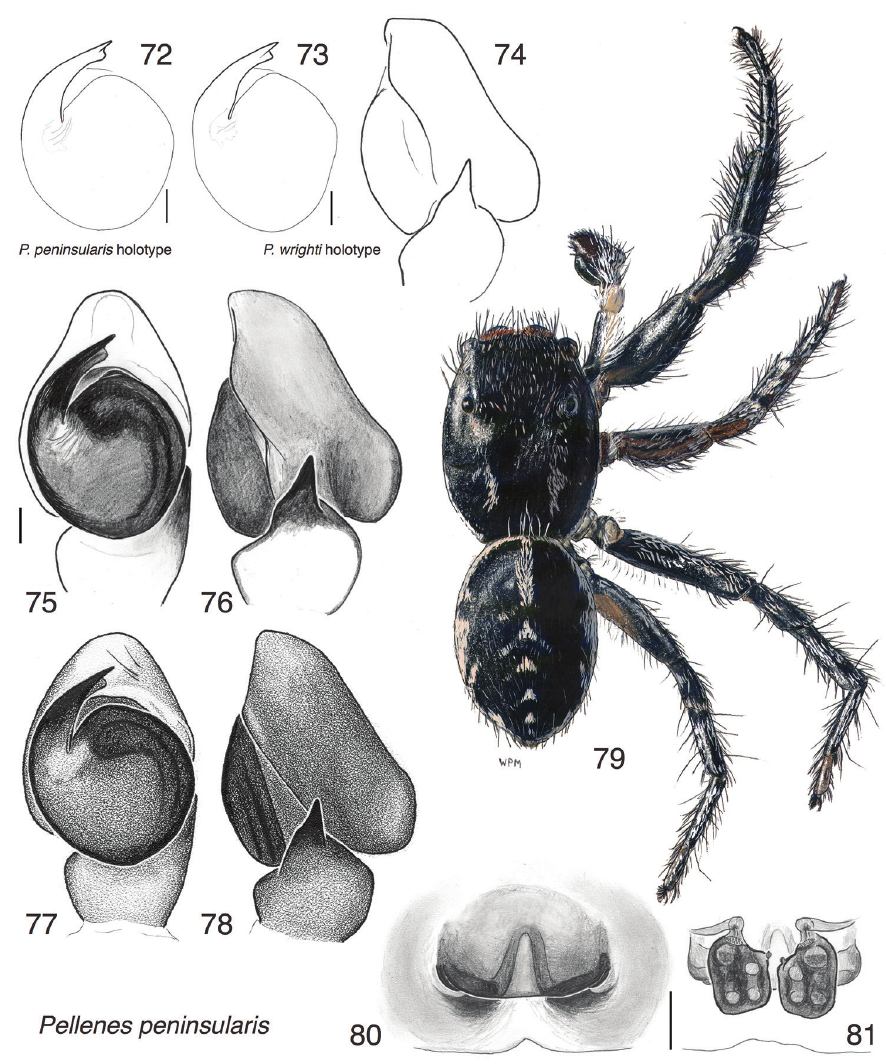
Figures 72–81. Pellenes peninsularis . 72 Bulb of left palp, holotype of Pellenes peninsularis Emerton, 1925 73–74 Left palp, holotype of Pellenes wrighti Lowrie & Gertsch, 1955 75–76 Left palp, male from Nova Scotia (DRM02.103) 77–78 Left palp, male from east-central Ontario (WPM#76-133) 79 Male from east-central Ontario (WPM#76-133) 80 Epigynum, ventral view, female from Nova Sco- tia (DRM02.103) 81 Epigynum, cleared, dorsal view, same female. DRM and WPM collecting codes are those indicated in specimen